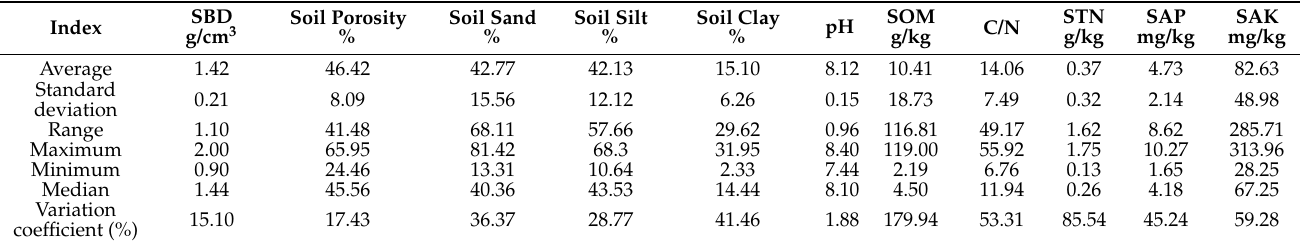
Table 1. Soil physicochemical properties in the study area ( n =